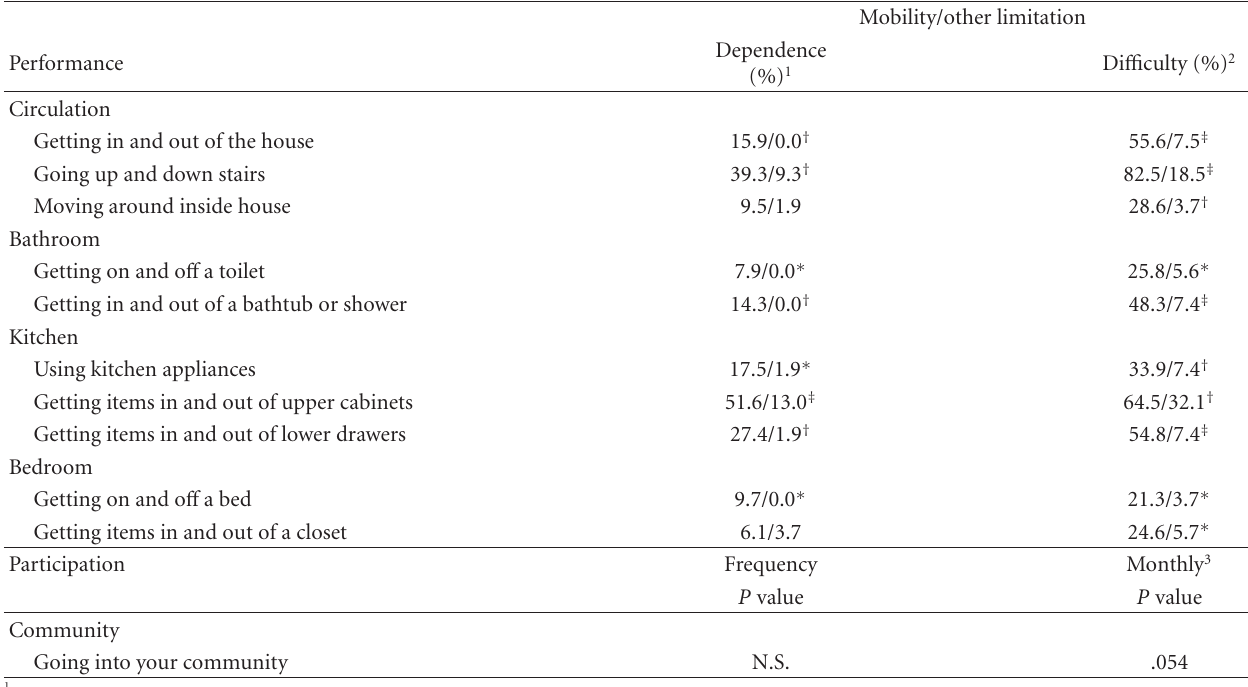
Table 4: Comparisons of performance and participation between mobility and other limitation